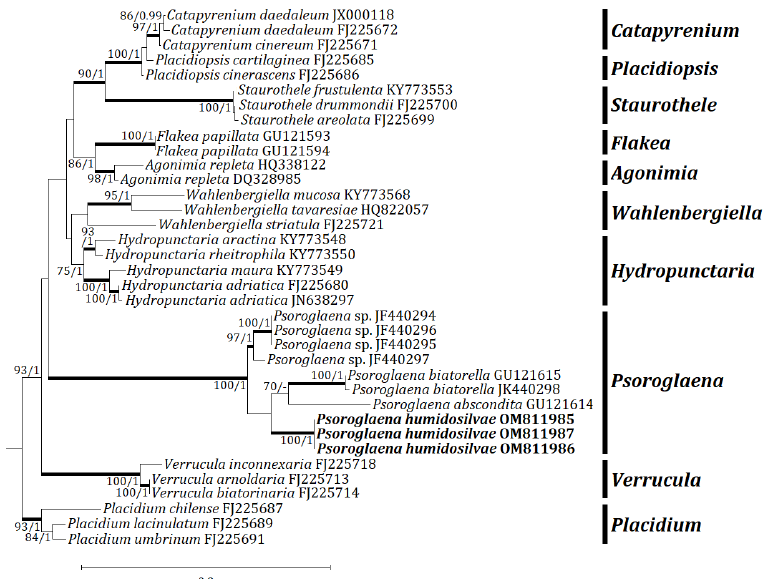
Figure 3. Phylogenetic relationships among available species in the genus Psoroglaena based on a maximum likelihood analysis of the dataset of mtSSU sequences. The tree was rooted with the sequences of the genus Placidium based on Muggia et al. [9]. Maximum likelihood bootstrap values ≥ 70% and posterior probabilities ≥ 95% are shown above internal branches. Branches with bootstrap values ≥ 90% are shown as fatty lines. The new species, P. humidosilvae , is presented in bold as their DNA sequences were produced from this study. All species names are followed by the GenBank accession numbers.